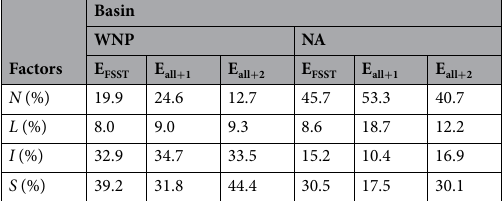
Table 1. Contributing factors to 10-year (2001–2010) averaged PDS change. Contributions of the TC case number ( N ), lifetime ( L ), intensity ( I ) and size ( S ) to the PDS changes in the SST sensitivity experiments (E FSST , E all + 1 , and E all + 2 ) compared to that in the CTRL experiments over the WNP and